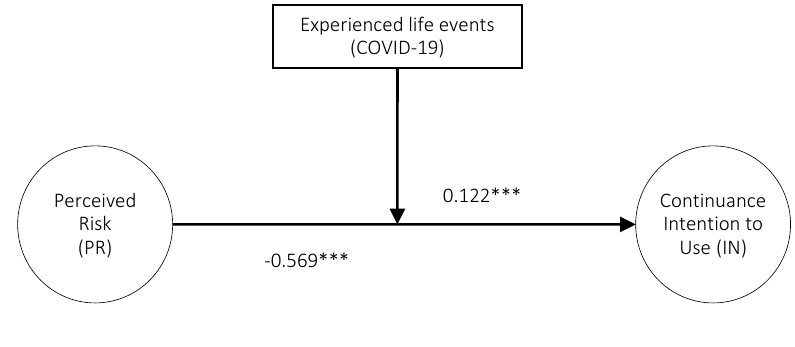
Figure 4. Influence of the moderating variable of experienced life event of the COVID-19